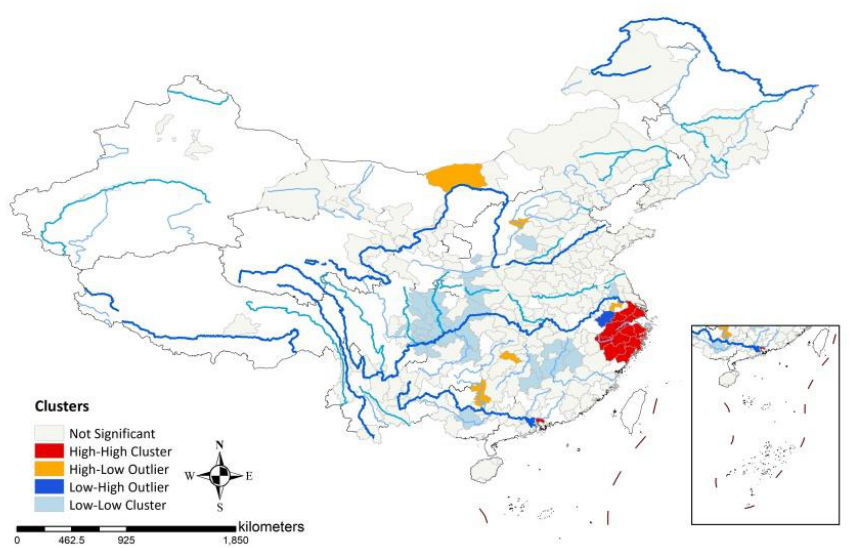
Figure 3. Spatial autocorrelation map of TC incidence in 2016. Note: The blank areas had no available registration data. The blue lines of different shades and thicknesses represented the water system. The darker and the thicker the line was, the higher the stream order. The first order stream was the highest order.